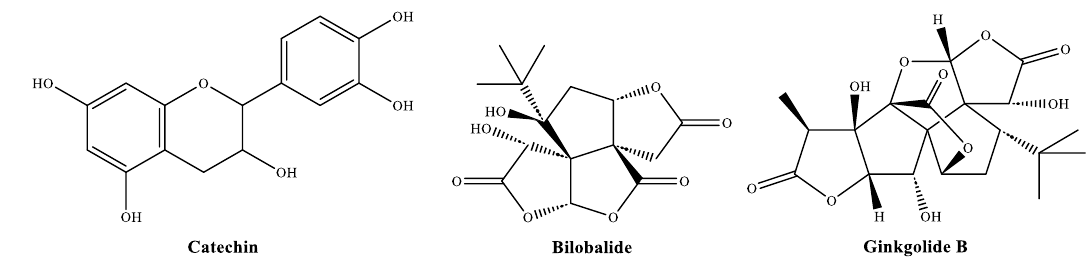
Figure 2. Specific components of Ginkgo biloba leaf extracts reported by Lin et al. [6] .